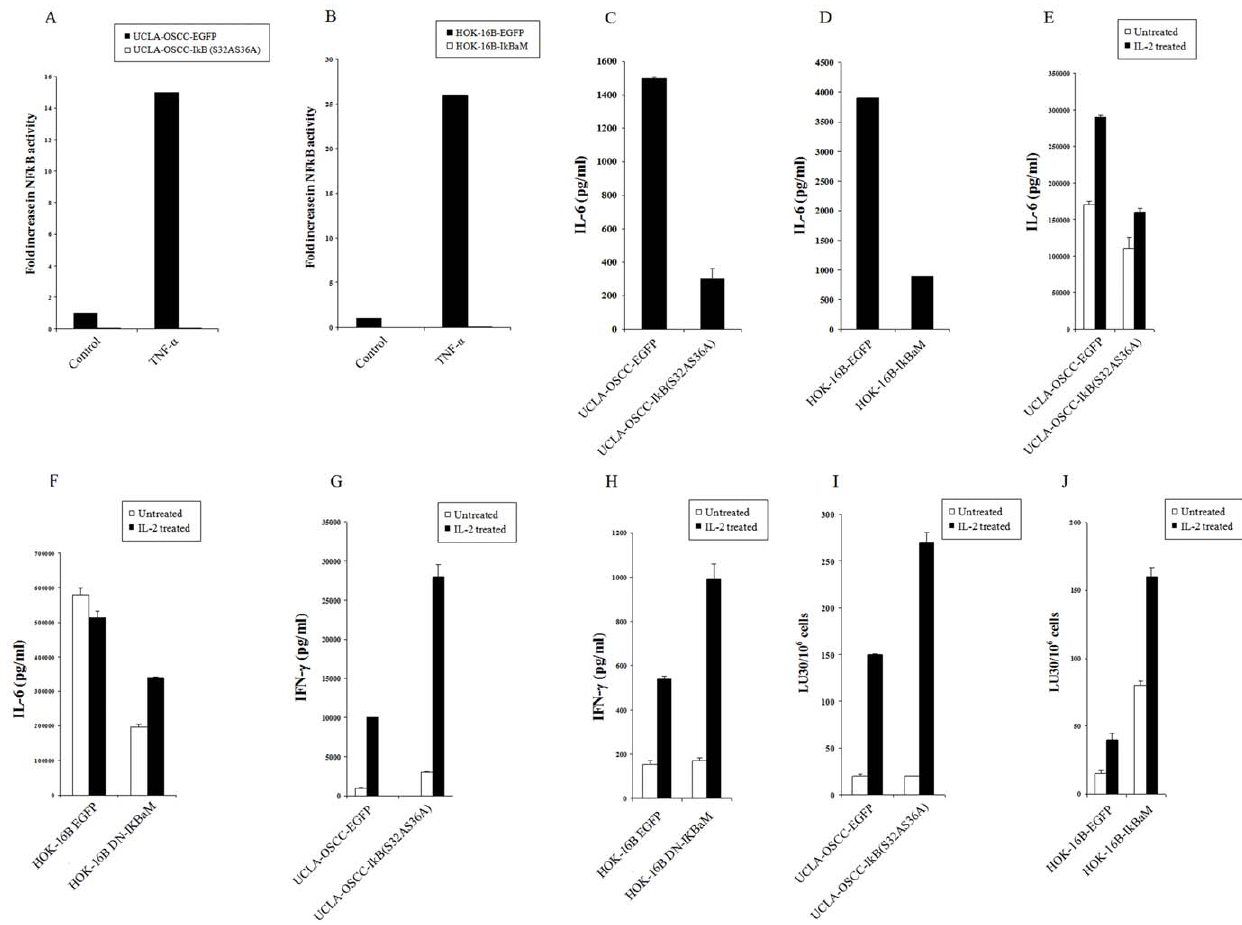
Figure 2. Increased cytotoxicity, decreased secretion of IL-6 and increased secretion of IFN- c in co-cultures of NK cells with NF k B knock down UCLA-OSCCs and HOK-16B cells. I k B (S32AS36A) transduced UCLA-OSCCs ( A ) and I k B a M transduced HOK-16B cells ( B ) and their EGFP transduced controls were transfected with 8 m g of NF k B Luciferase reporter vector and treated with and without TNF- a (20ng/ml) for 18 hours. The relative Luciferase activity was then determined in the lysates according to the manufacturer’s recommendation and fold induction in